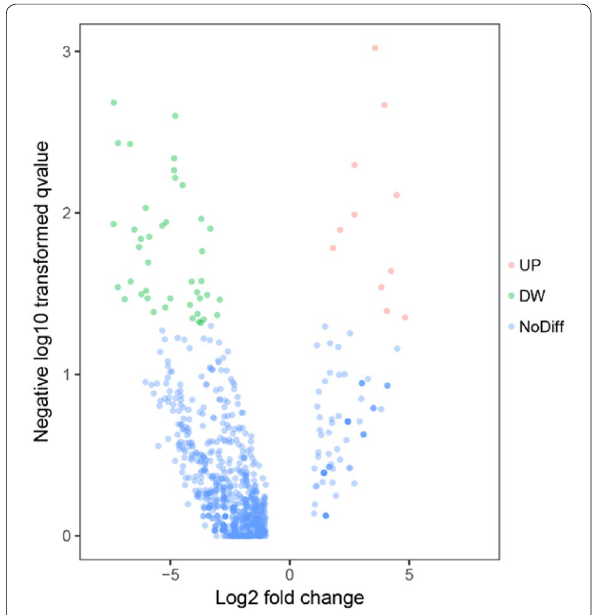
Fig. 3 Volcano plots of differentially expressed miRNAs ( p < 0.05) between LNIV-CC and control